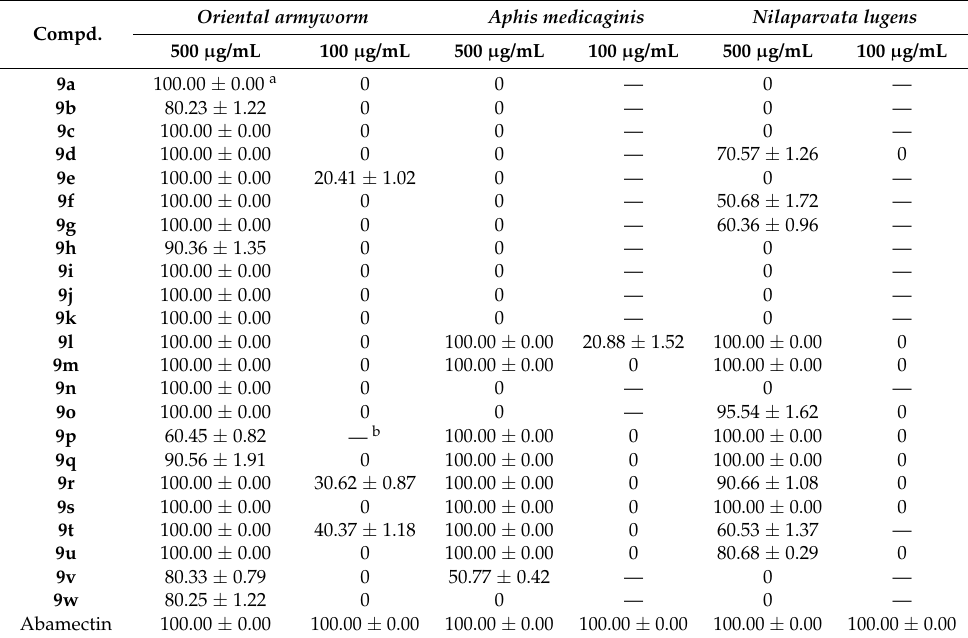
Table 2. Insecticidal activities of compounds 9a – 9w (mortality, %). Compd.